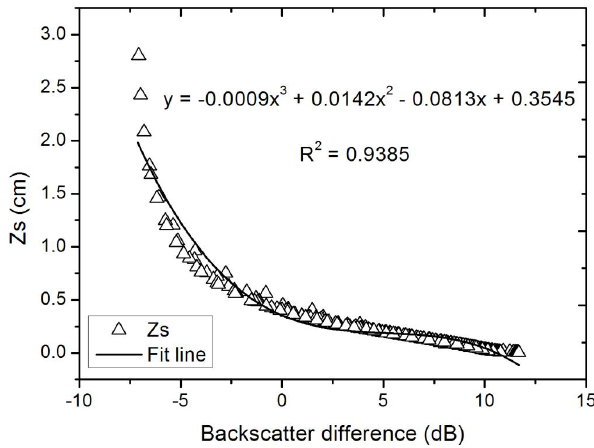
Fig. 4. Sketch map of the relationship between Zs and 1σ IS1 − IS7 (incidence angles of 18.4 ◦ and 43.9 ◦ ) provided by Eq. (11).